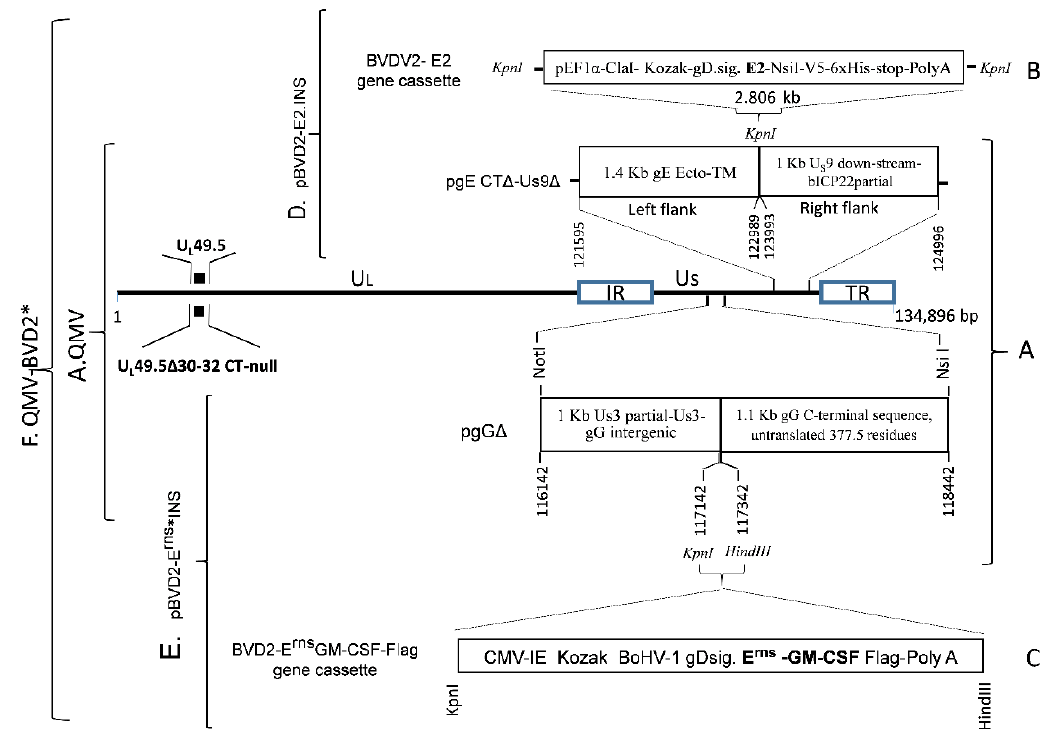
Figure 2. The strategy of chimeric BVD2 E2 and Erns–GM–CSF insertion in the gE CT–Us9 and gG deletion loci, respectively, of BoHV–1 QMV genome to generate BoHV–1 QMV–BVD2 E2–Erns–GM.CSF virus (QMV–BVD2*). ( A ) Schematic of BoHV–1 triple mutant virus (TMV) genomic organization showing unique long 49.5 (U L 49.5), gE CT/Us9 and gG deletions. Nucleotide numbers correspond to GenBank accession # JX898220. ( B ) Schematic of BVDV2–E2 expression cassette. ( C ) Schematic of BVDV2–Erns–GMCSF. Flag expression cassette (Erns*). ( D ) BVD2–E2 expression cassette cloned into the KpnI site of pgE CTΔ–Us9Δ to yield pBVD2–E2.INS. ( E ) BVDV2–Erns* expression cassette cloned into the KpnI–HindIII restriction sites of pgGΔ to yield pBVD2–Erns* INS. ( F ) Incorporation of BVDV E2 and Erns* expression cassettes into the BoHV–1 QMV to yield BoHV–1 QMV–BVD2*.